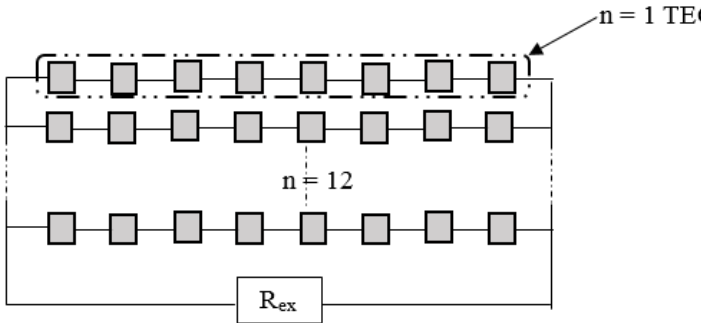
Figure 2. Photographic view of the waste heat recovery system using thermoelectric gen ‐